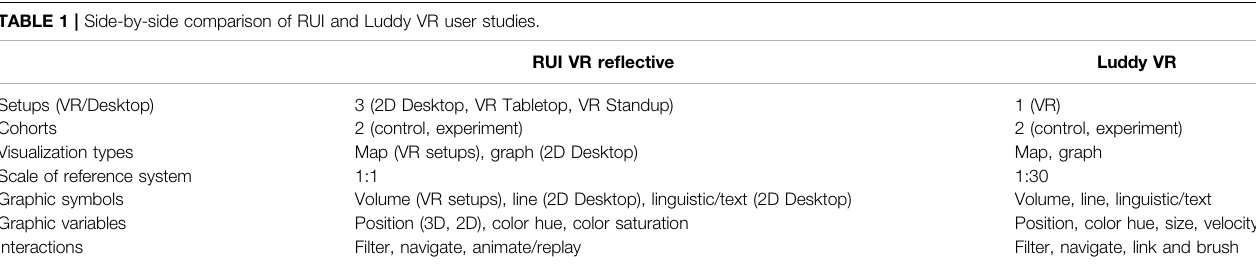
FIGURE 1 | General design of our studies with two cohorts. The purple asterisk marks the part of the experiment where we determined differences in post- treatment performance between the two cohorts.